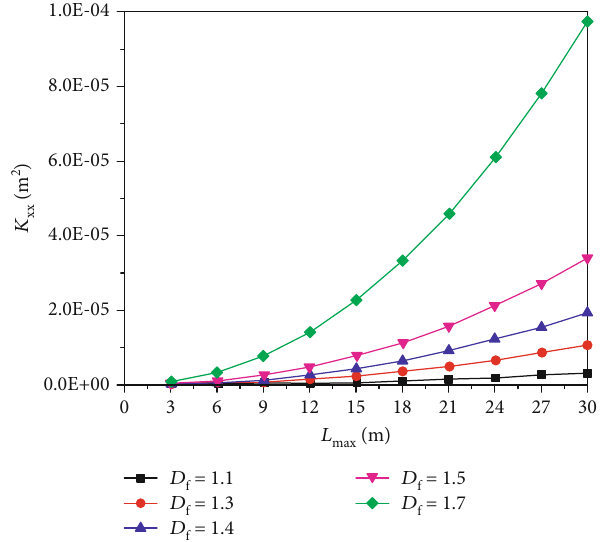
Figure 11: The relationship between L β = 0 : 01 , θ = π /6 , and α = π /2 ).